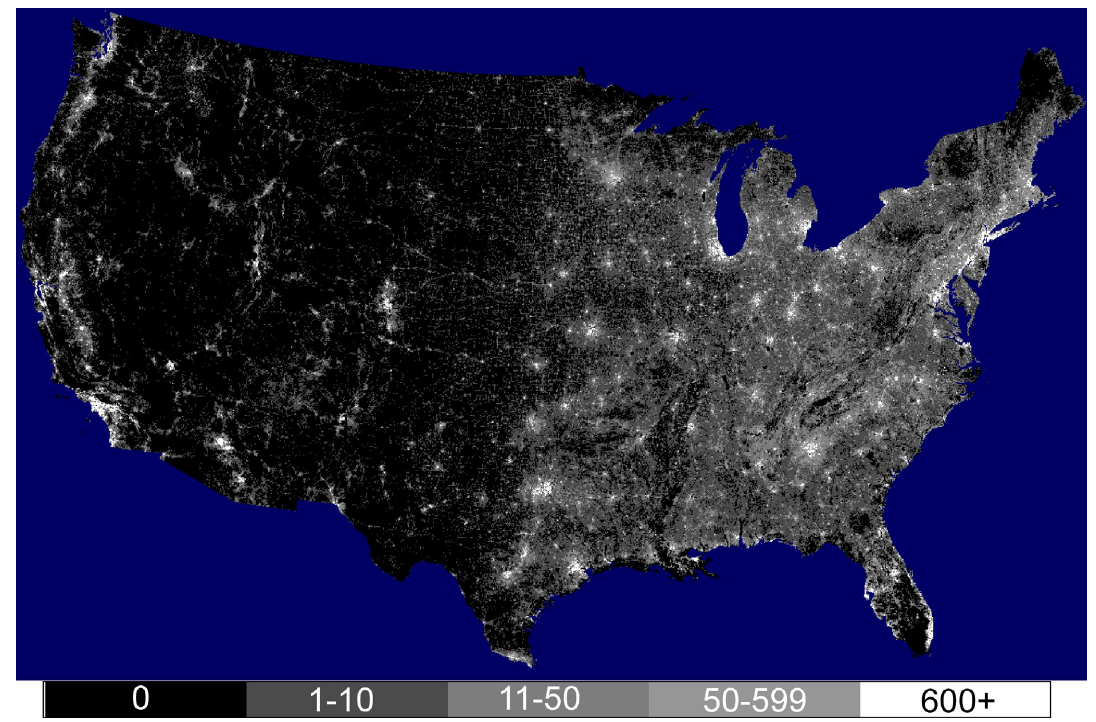
Figure 3. Landscan 2004 population count data of the conterminous USA. The figure shows population count in five gray scale